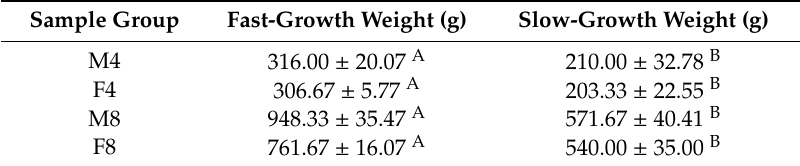
Table 2. Body weights of four-week-old and eight-week-old individuals in the fast- and slow-growth